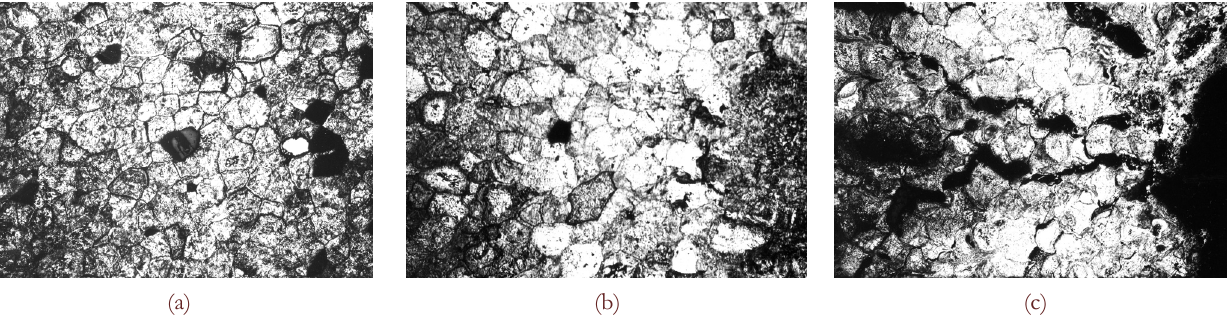
Figure 3: The structures of the cross sections of the samples for three different values of D and at the same thickness of explosive charge – 5 mm: a) D =3.19 km/s; b) D =3.95 km/s; c) D =5.26